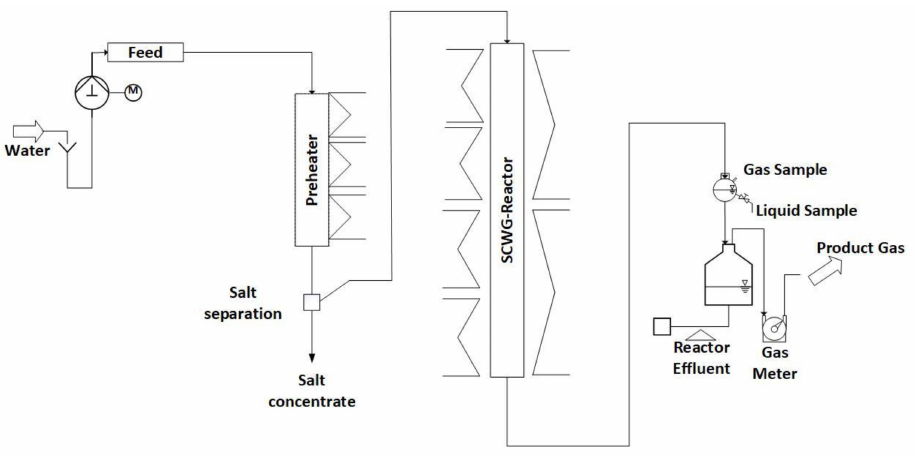
Figure 3. High-pressure laboratory equipment for supercritical water